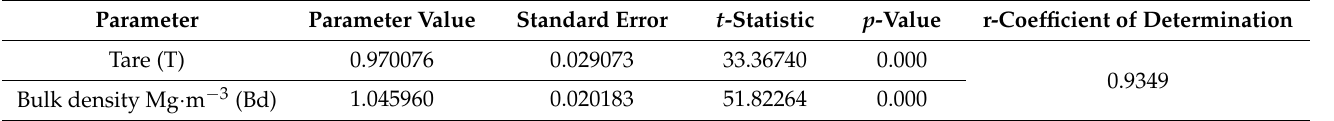
Table 6. Evaluation of model parameters for the bulk volume of the chips load.